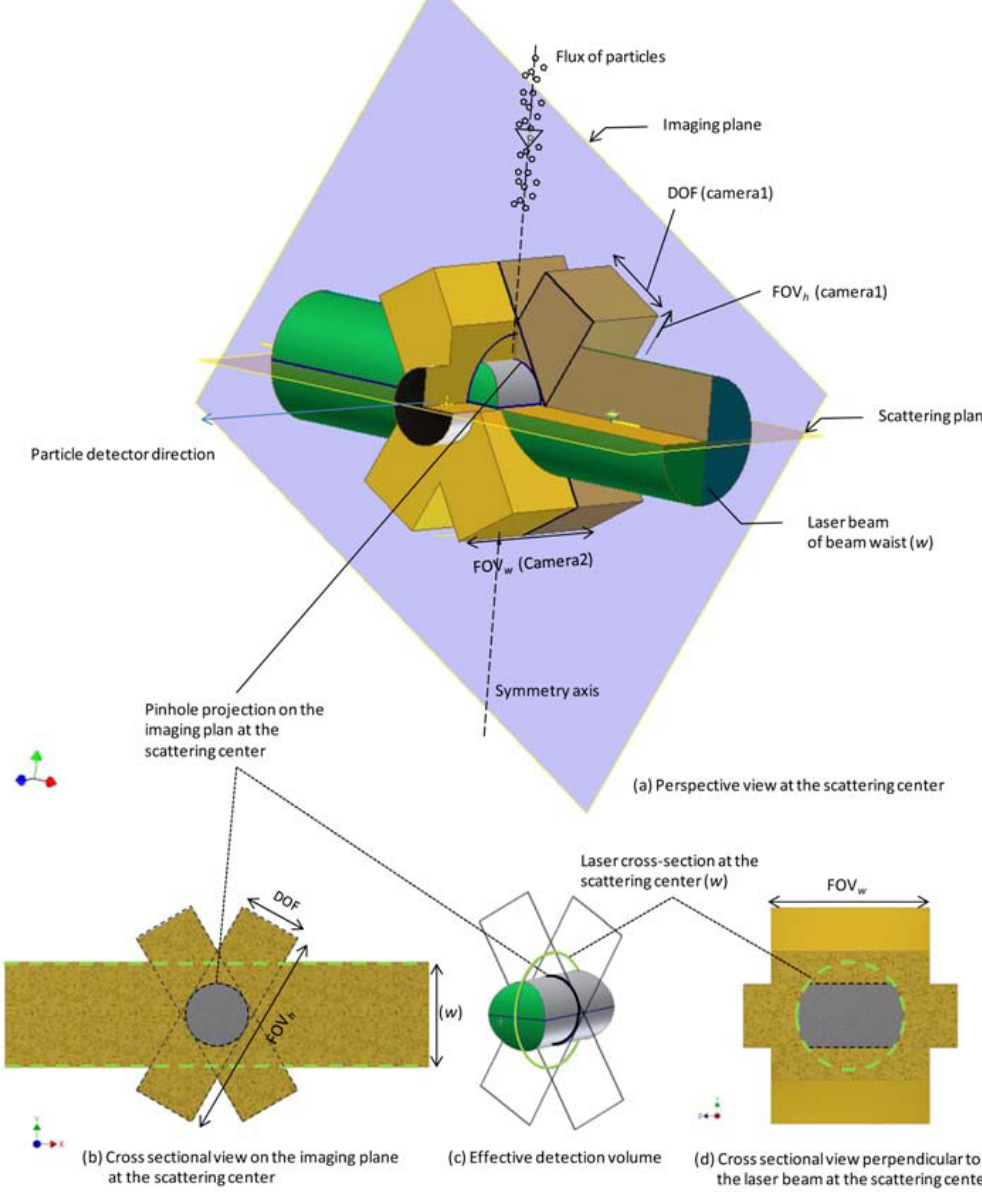
Fig. 2. The intersection of the laser beam, the FOV × DOF and the projection of the pinhole (placed in the particle detector optics) at the scattering center. (a) A perspective view, (b) a cross sectional view of on the imaging plane at the scattering center, (d) a cross sectional view perpendicular to the laser beam at the scattering center, and (c) the effective detection volume of PHIPS. DOF: Depth-of-field, FOV h : Field-of-view height, and FOV w : Field-of-view width. DOF (camera2), FOV h (camera2) and FOV w (camera1) are not indicated on the drawing for clarity.